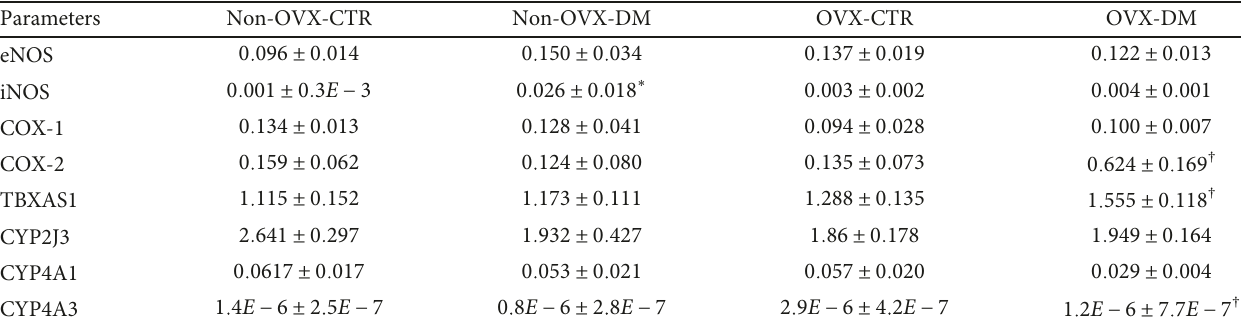
Table 2: Relative mRNA expression of eNOS, iNOS, COX-1, COX-2, TBXAS1, CYP2J3, CYP4A1, and CYP4A3 in thoracic aorta tissue.